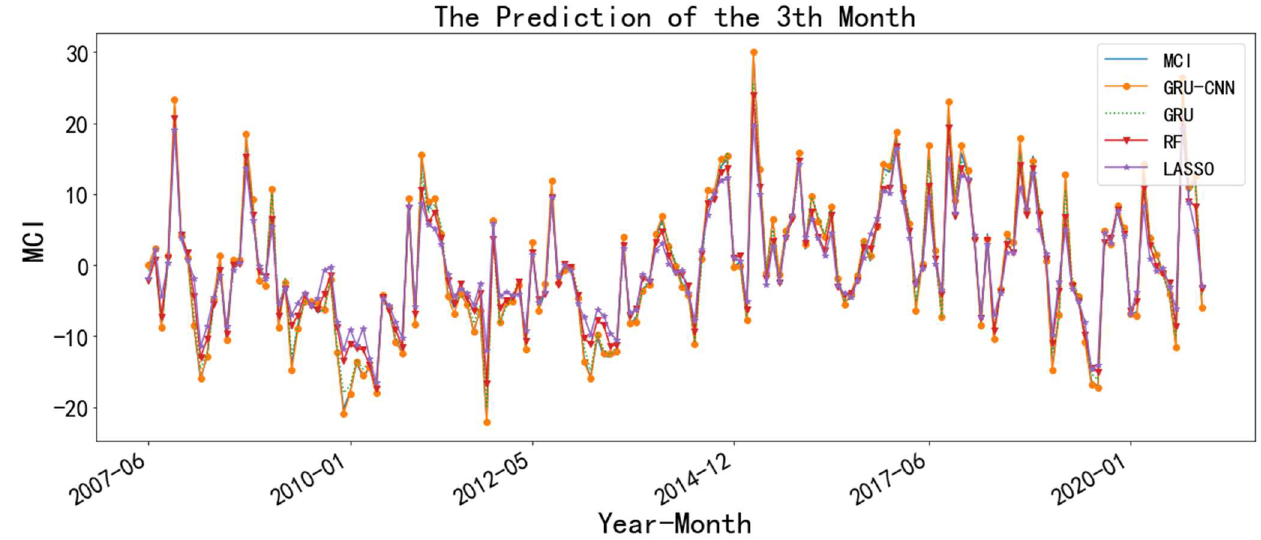
Figure 9. The prediction of the MCI at the Lincang station with 3-month leading.